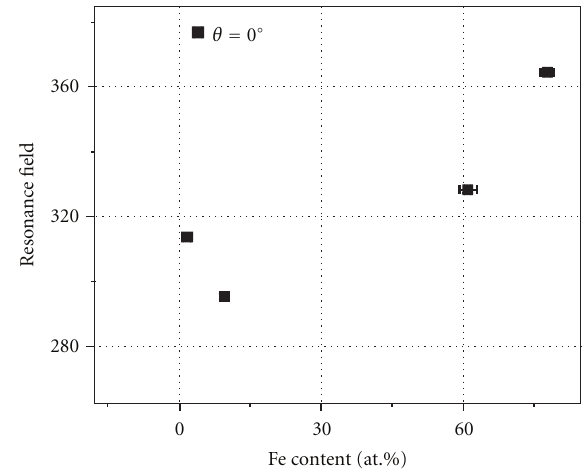
F 2: FMR intensity of the thin �lms as a function of iron content. ese NPs embedded on Si substrate by a self-assembly are spherical.